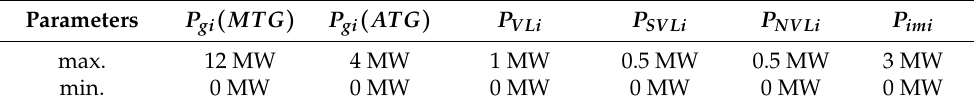
Table 3. Simulation